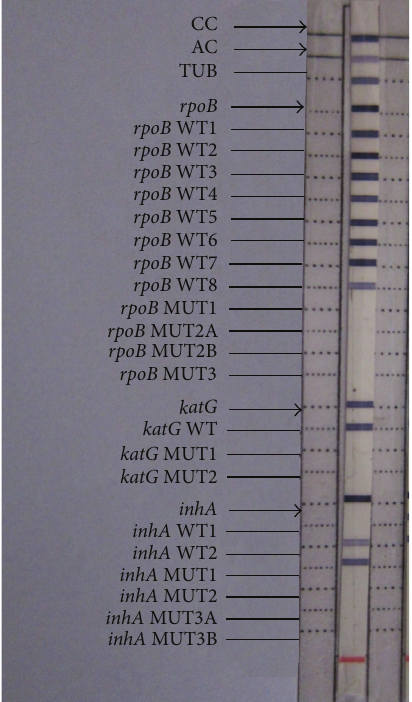
Figure 5: Patient showing low level INH monoresistance with absent inhA WT1 band and presence of inhA MUT1